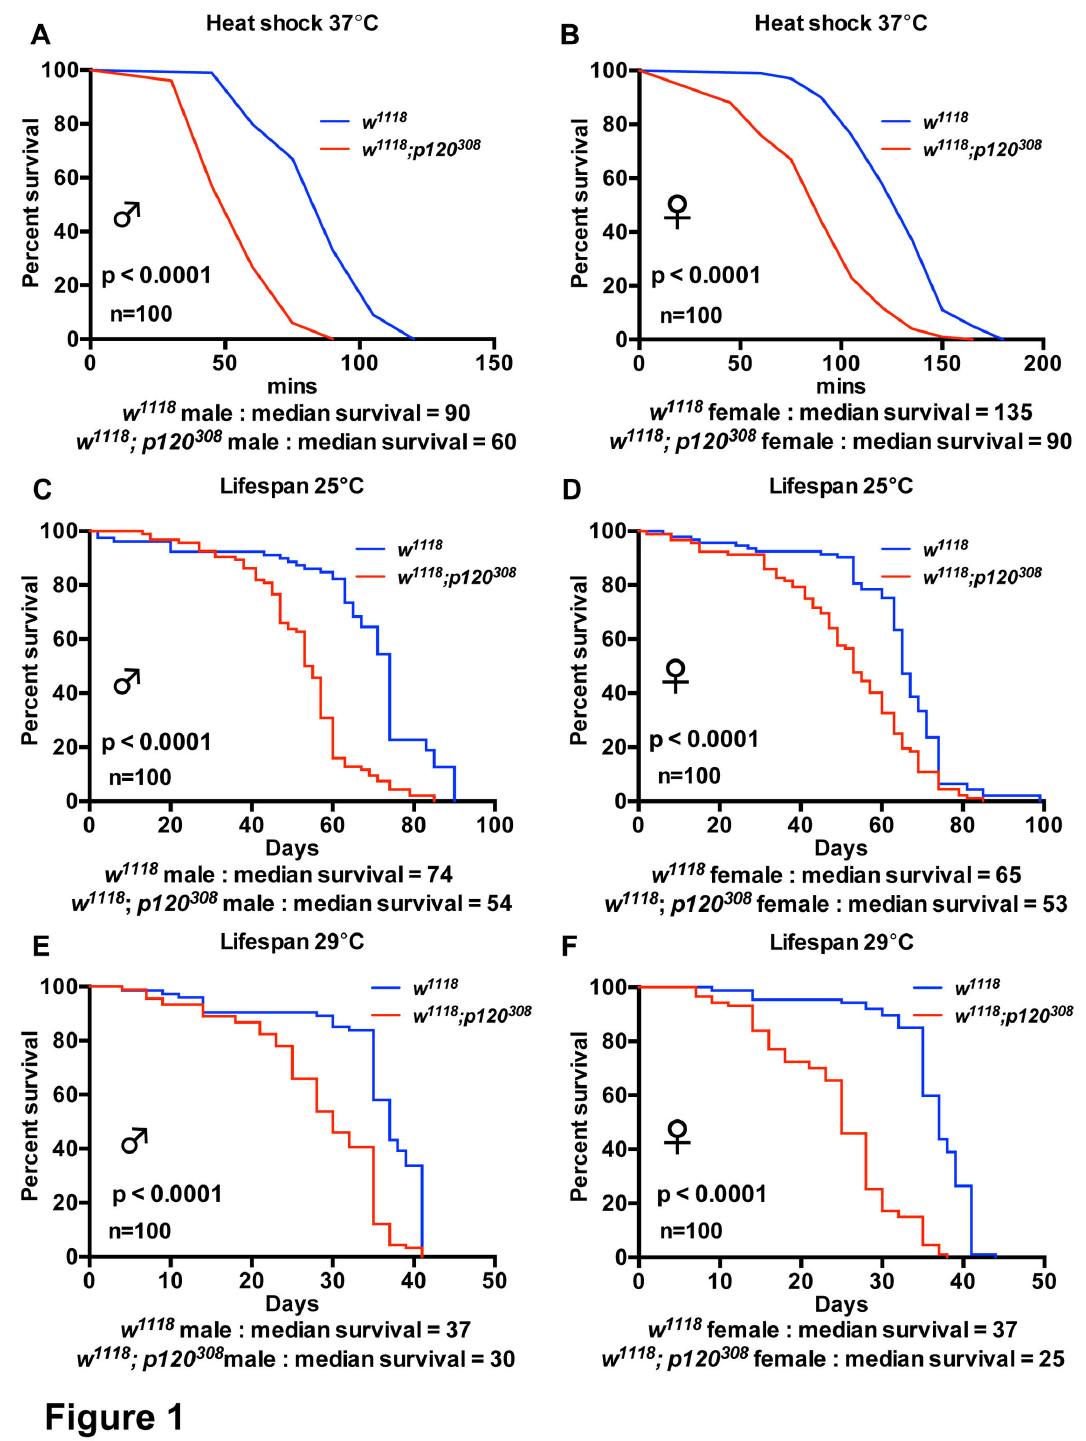
Figure 1. dp120ctn mutants are sensitive to heat shock and have a reduced median lifespan. (A-B) Survival of w 1118 and w 1118 ; p120 308 males and females under heat shock conditions. Percent survival was plotted versus time in minutes under heat shock at 37°C. (C-F) Lifespan of w 1118 and w 1118 ; p120 308 males and females at 25°C and 29°C. Survival was plotted as adult lifespan in days. Blue lines indicate w 1118 controls and red lines w 1118 ; p120 308 . Each curve represents 100 flies. Median survival is presented for each cohort as well as p values generated using log-rank tests. doi: 10.1371/journal.pone.0083942.g001 PLOS ONE |